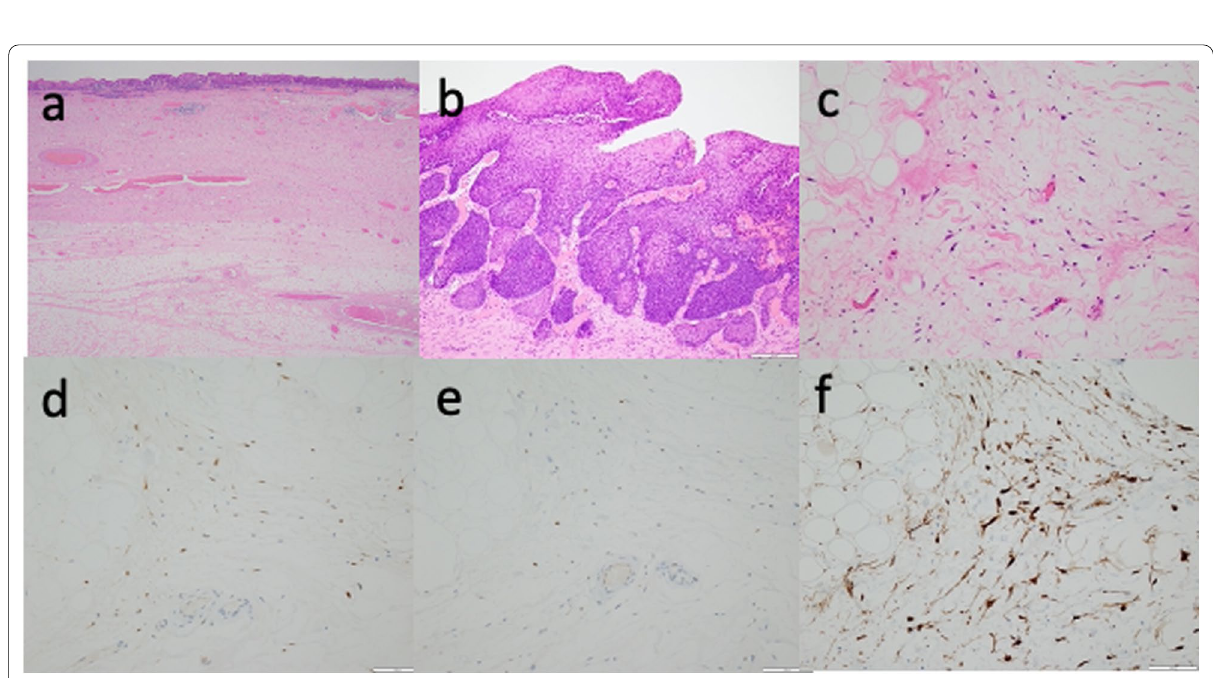
Fig. 5 Histopathological examination. a superficial squamous carcinoma located on the surface of liposarcoma. b Proliferation of atypical squamous epithelium cells and invasion into the stroma in a part of the tumor. The depth of invasion was 930 μm. c Most tumors were composed of adipocytes and spindle cells with atypical nuclei. ( a 1 atypical lipoblasts positive for CDK4 ( d ), weakly positive for MDM2 ( e ), and positive for p16 in the nuclei ( f ). ( d , e , and f All 20